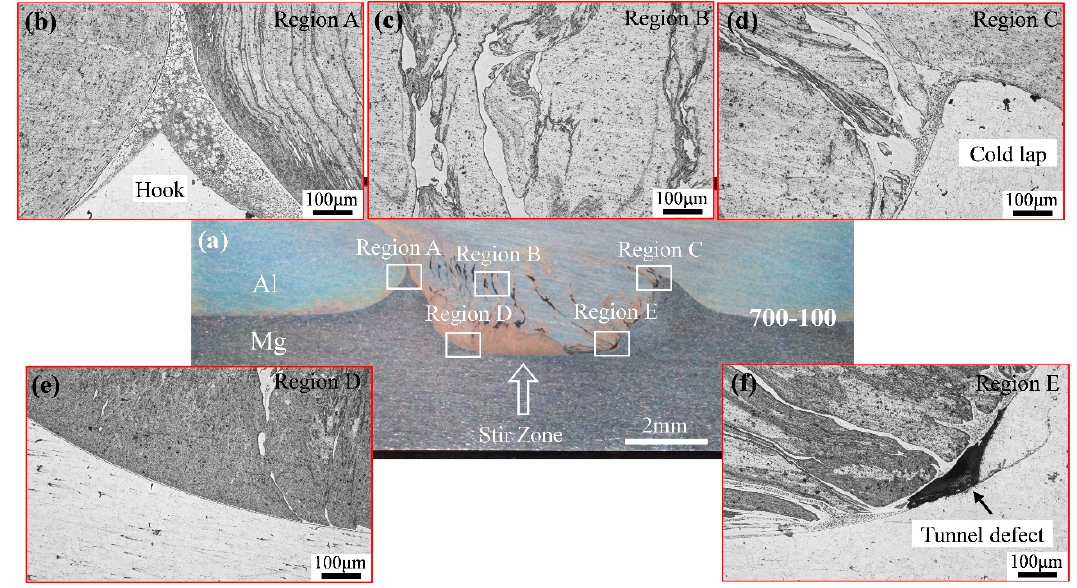
Figure 6. Macrostructure and microstructure of the joint welded in Configuration Al-Mg at 700 rpm: ( a ) macro structure; ( b ) hook; ( c ) SZ; ( d ) cold lap; ( e ) SZ bottom at the AS; ( f ) SZ bottom at the RS.